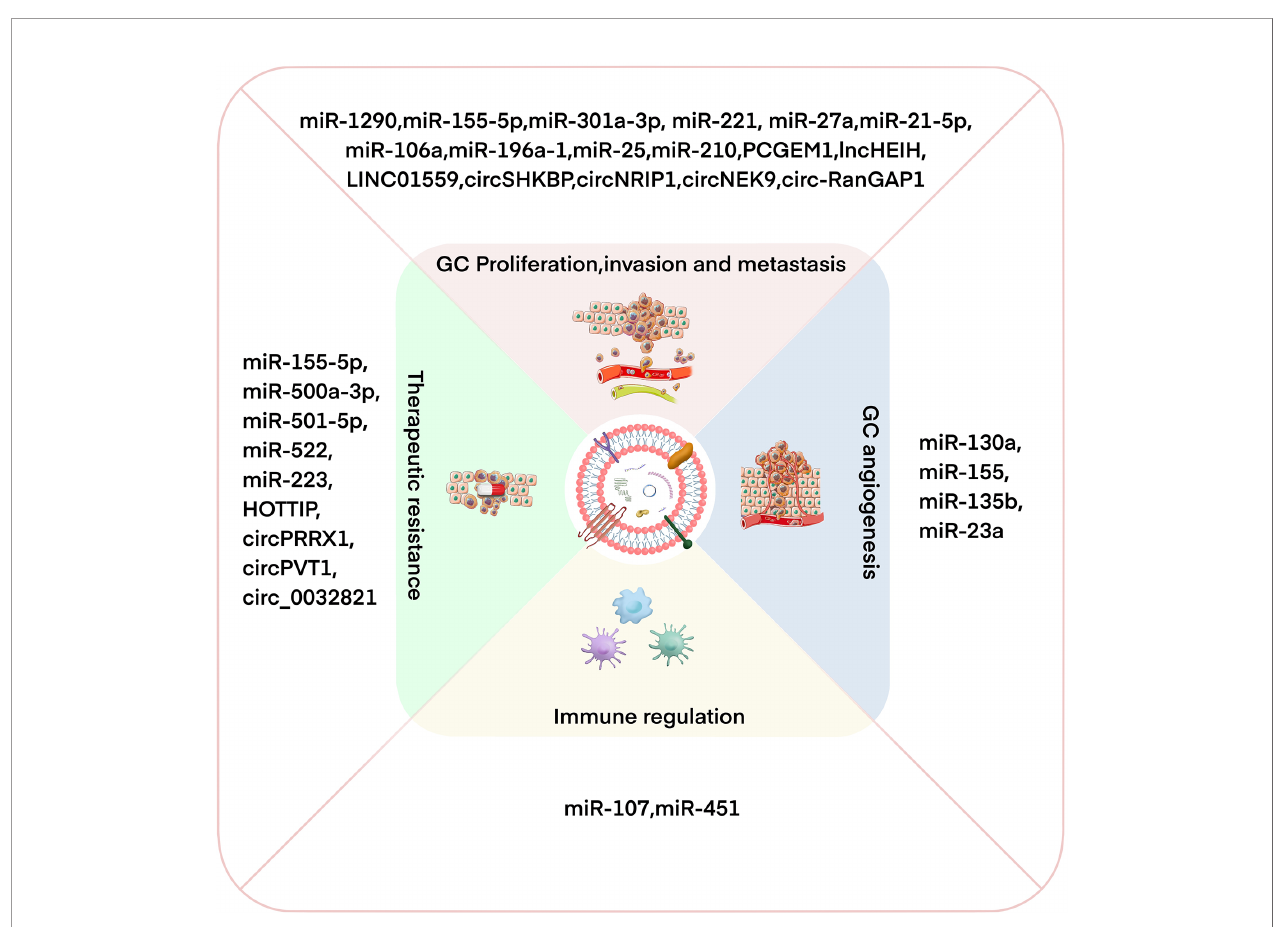
FIGURE 2 | Exosomal ncRNAs have important effects on regulating GC proliferation/invasion/metastasis, angiogenesis, immune regulation, and therapeutic